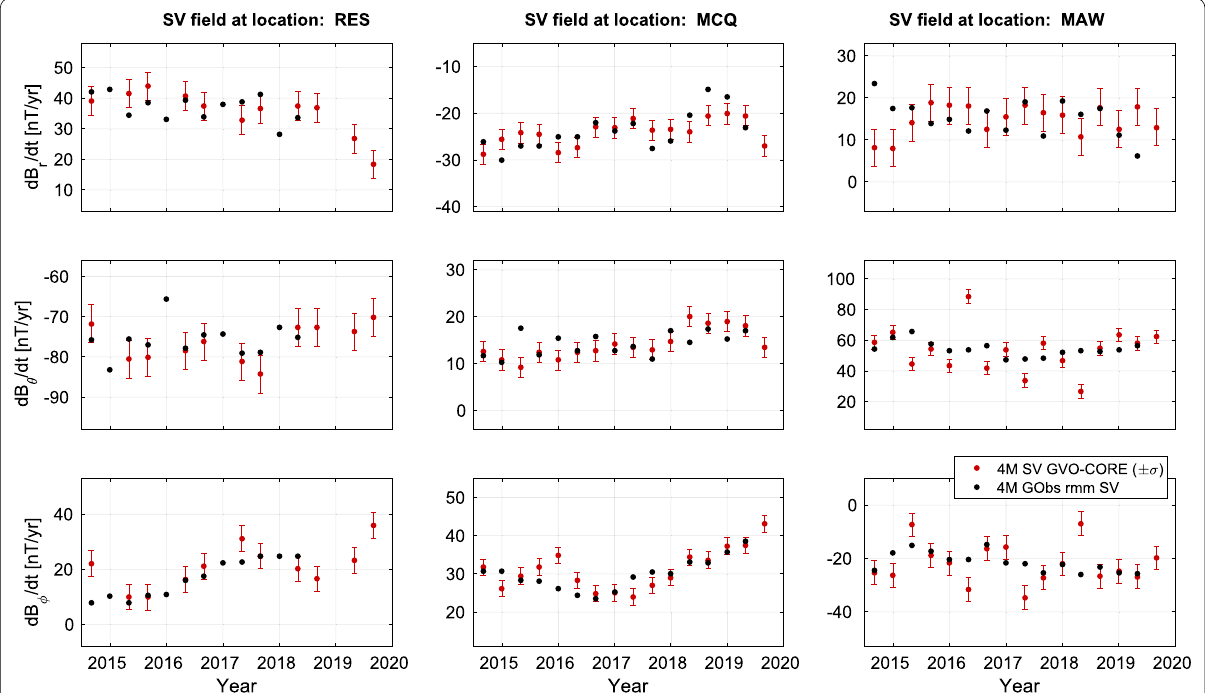
σ uncertainties, and 4-monthly revised means from ±